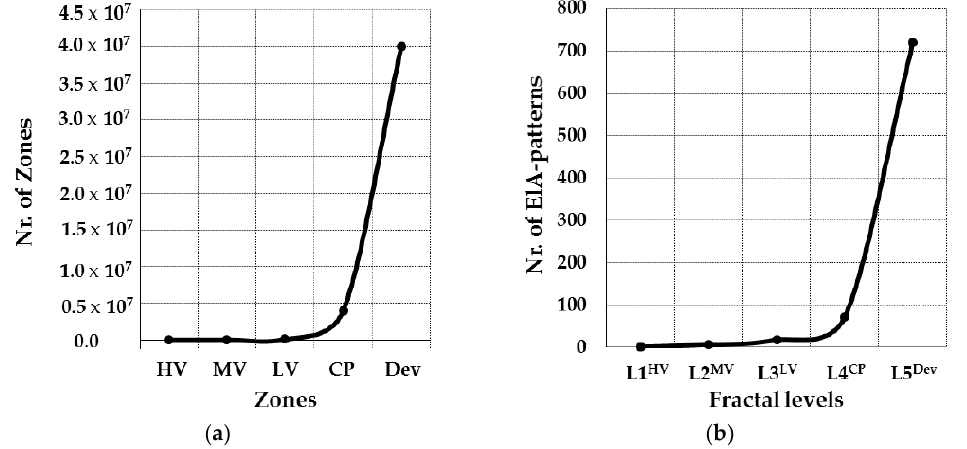
Figure 4. Overview of the structure of smart grids: ( a ) Real conditions; ( b ) fractal.